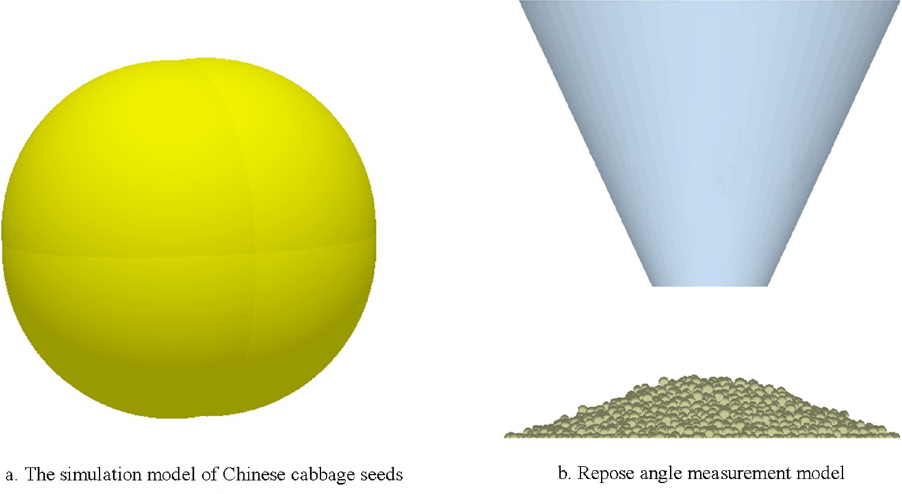
Fig 5. Measurement model of simulation test of repose